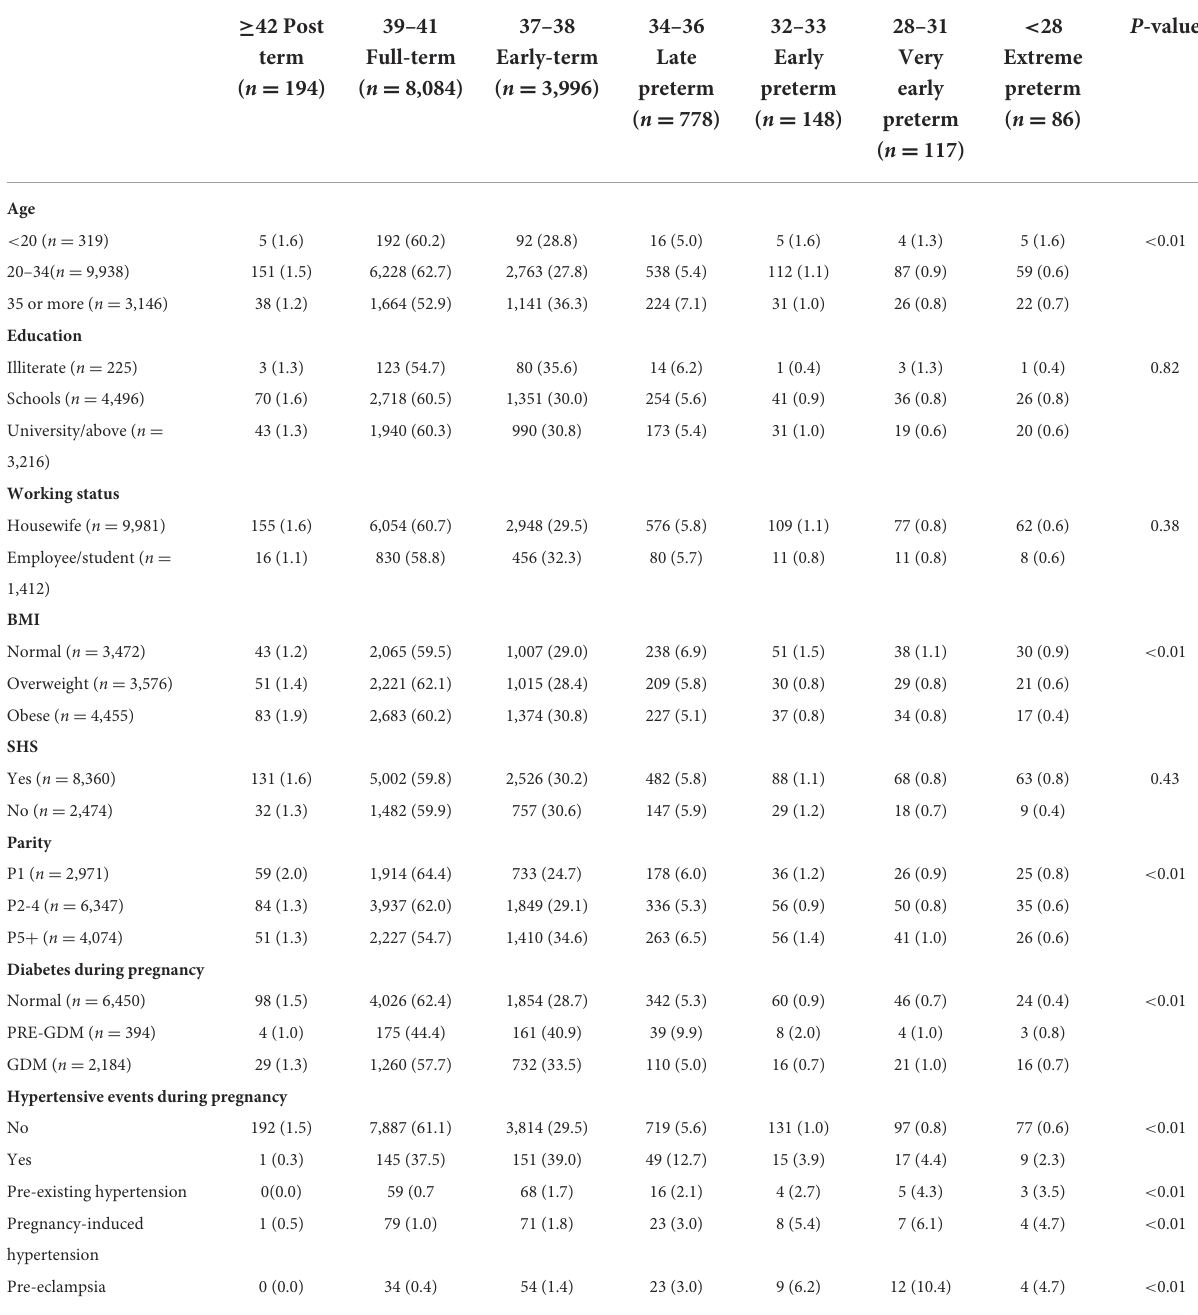
TABLE 1 Maternal demographic characteristics by gestational age at